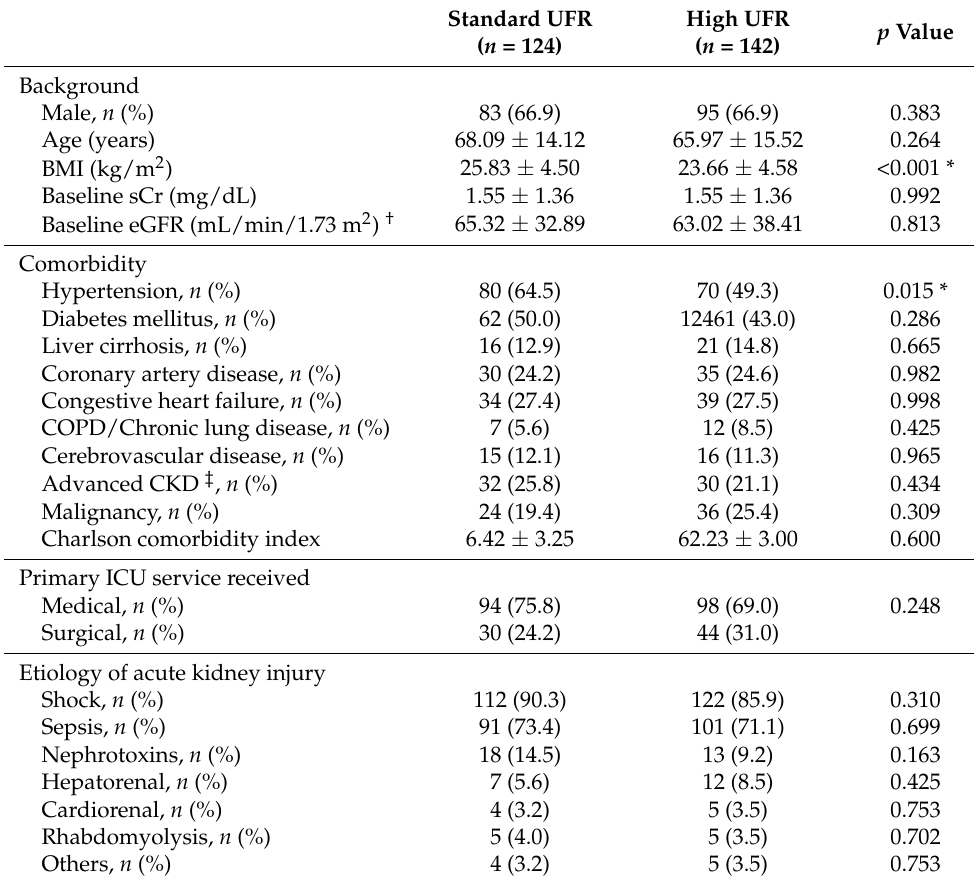
Table 1. Demographic data of patients that were receiving continuous venovenous hemofiltration at standard versus high ultrafiltration